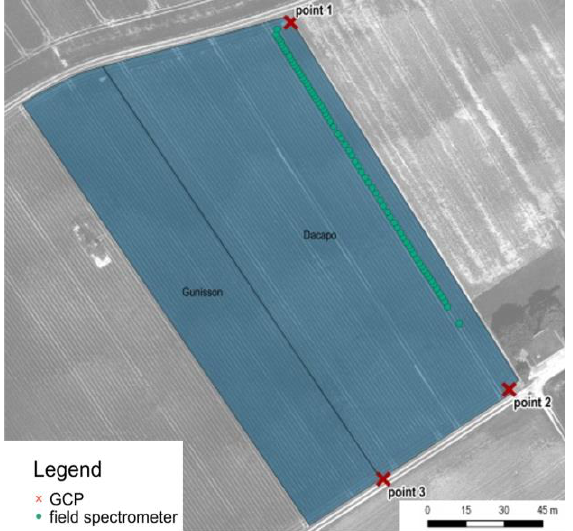
Figure 5. Onion field (15.07.14) with spectrometer measure- ments (light green dots) and GCP positions (red crosses).